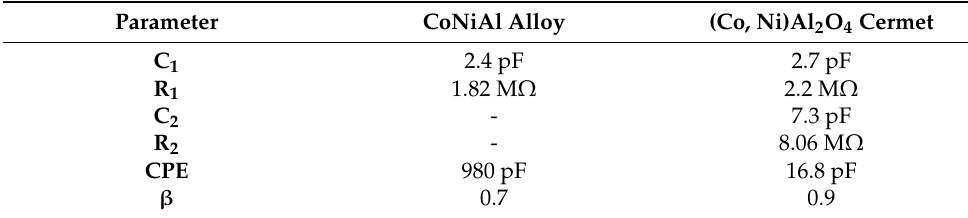
Table 2. Complex impedance